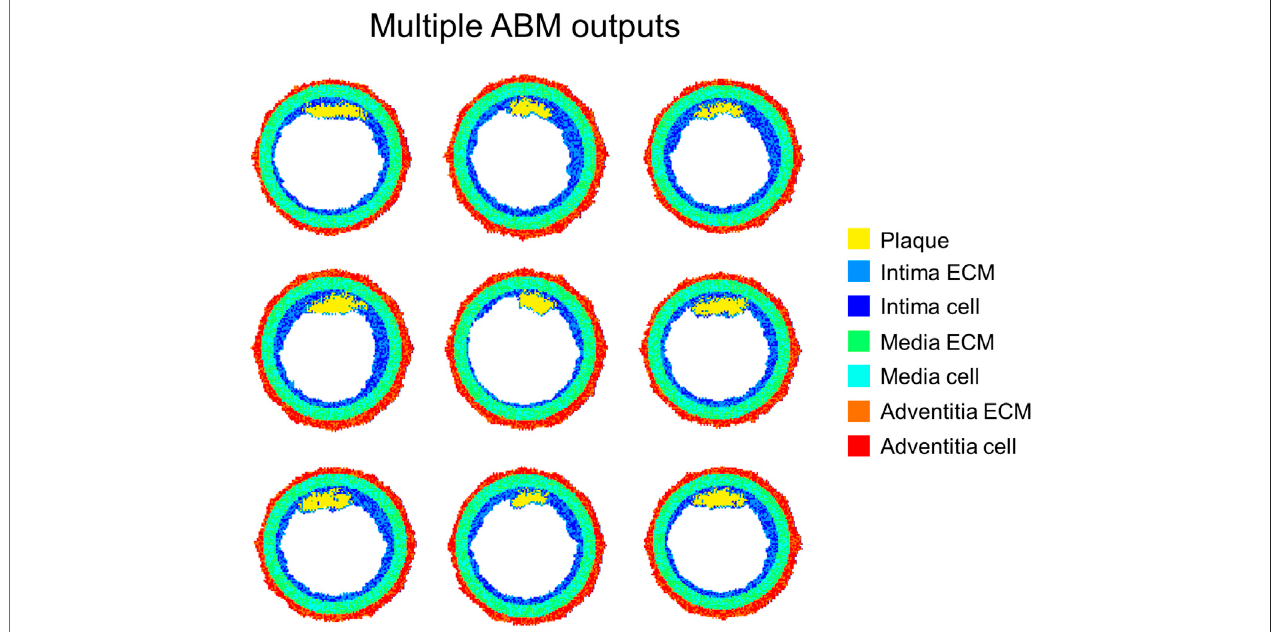
FIGURE 12 | Agent-based model (ABM) outputs at 2-months follow-up obtained from 9 independent simulations of the same ABM cross-section initialized with equal WSS pro fi le. Figure inspired from the work of Corti et al. (2020).